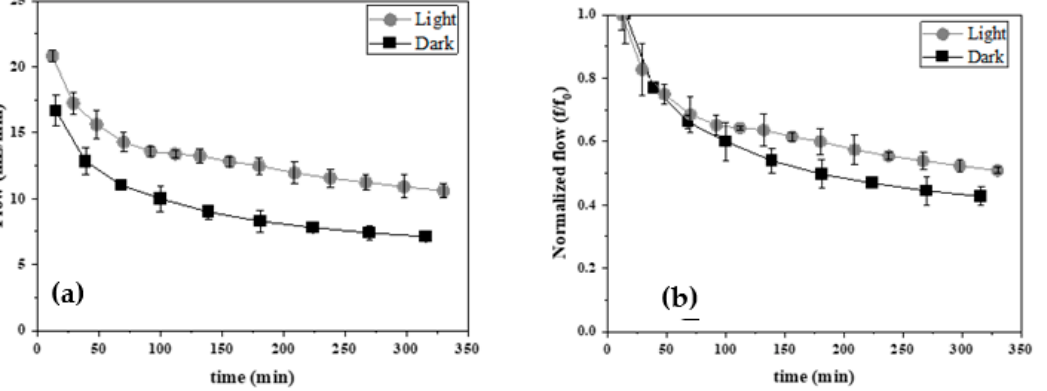
Figure 5. Filtration experiments with UWWTP effluent: ( a ) flow rates (mL/min) in the dark and in the light; ( b ) normalized flow rates (f/f 0 ) in the dark and in the light.